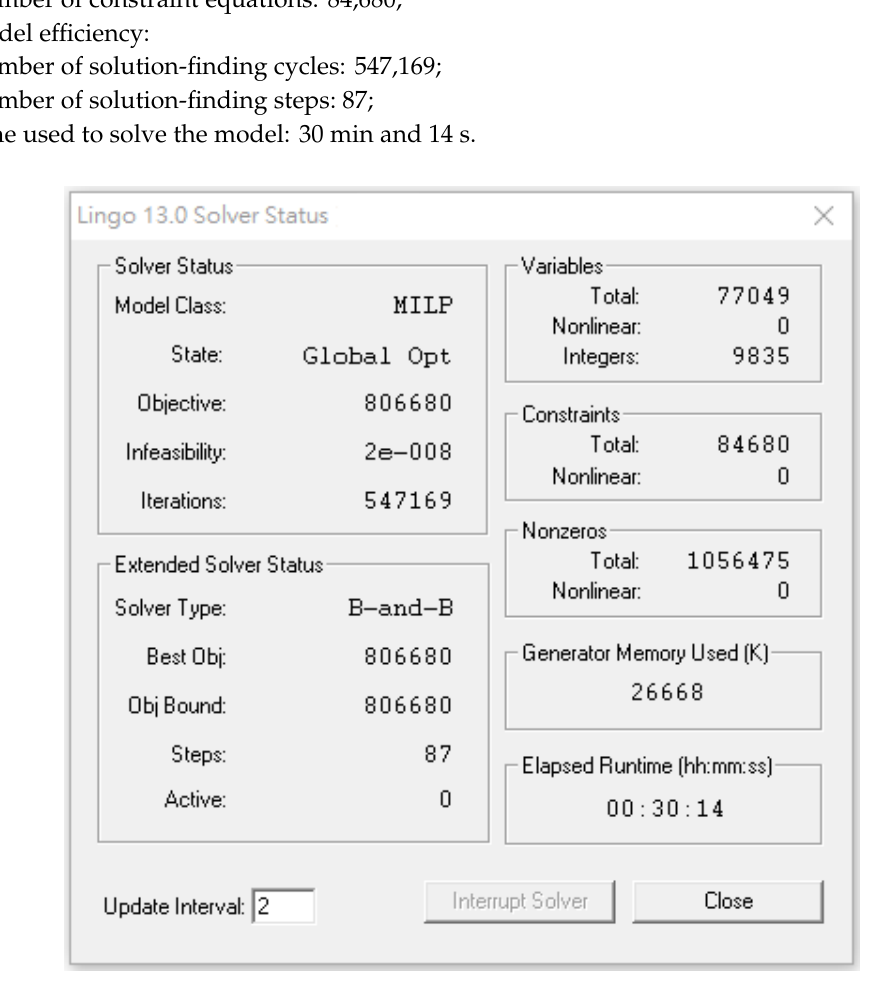
Figure 3. Screen of the solution output by